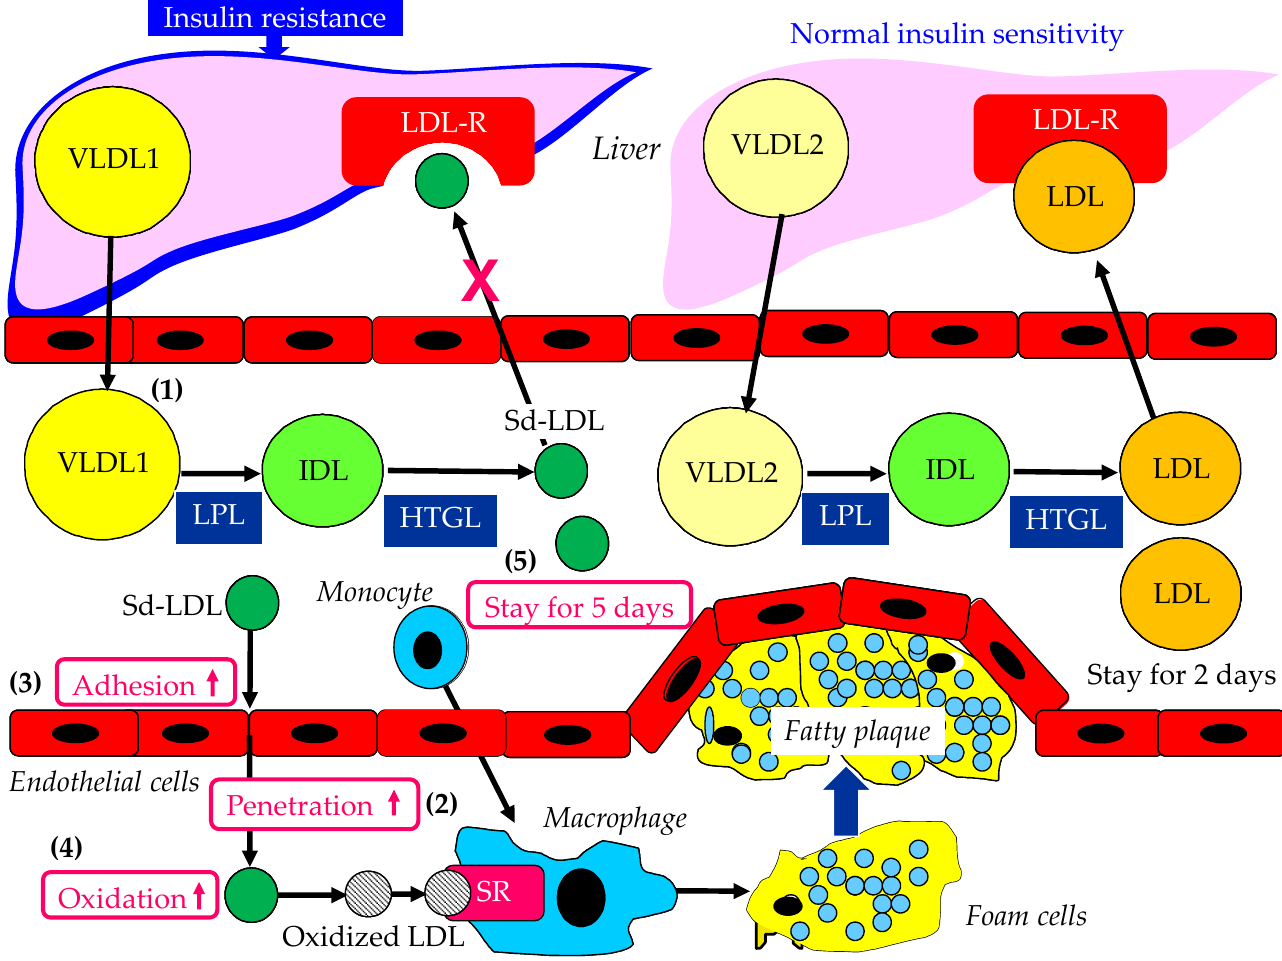
Figure 3. Atherogenic properties of Sd-LDL. Red cross indicates the reduced LDL receptor affinity of sd-LDL. HTGL: hepatic triglyceride lipase; IDL: intermediate-density lipoprotein; LDL: low-density lipoprotein; LDL-R: low-density lipoprotein receptor; LPL: lipoprotein lipase; Sd-LDL: small dense low-density lipoprotein; SR: scavenger receptor; VLDL: very-low-density lipoprotein.